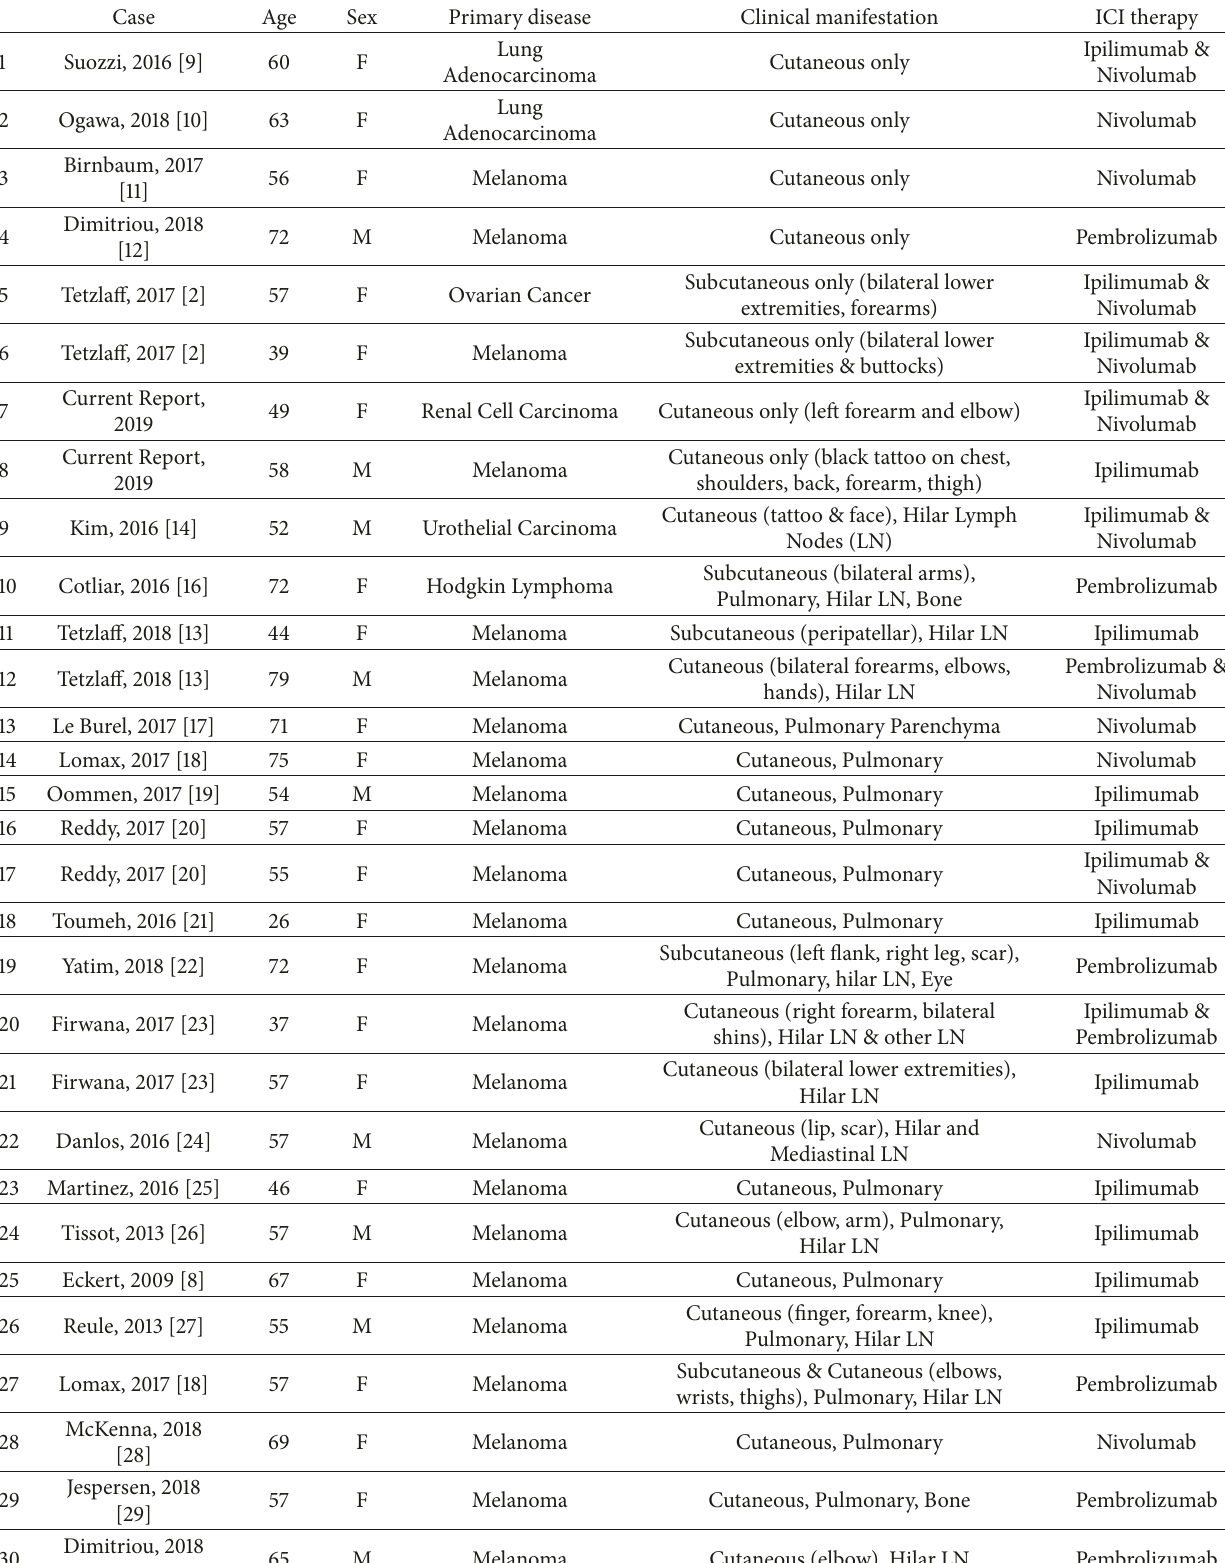
Table 1: Sarcoidal-type granulomatous reaction due to immune checkpoint inhibitors (anti-CTLA-4 and anti PD-1 antibodies), affecting skin, with and without other organ